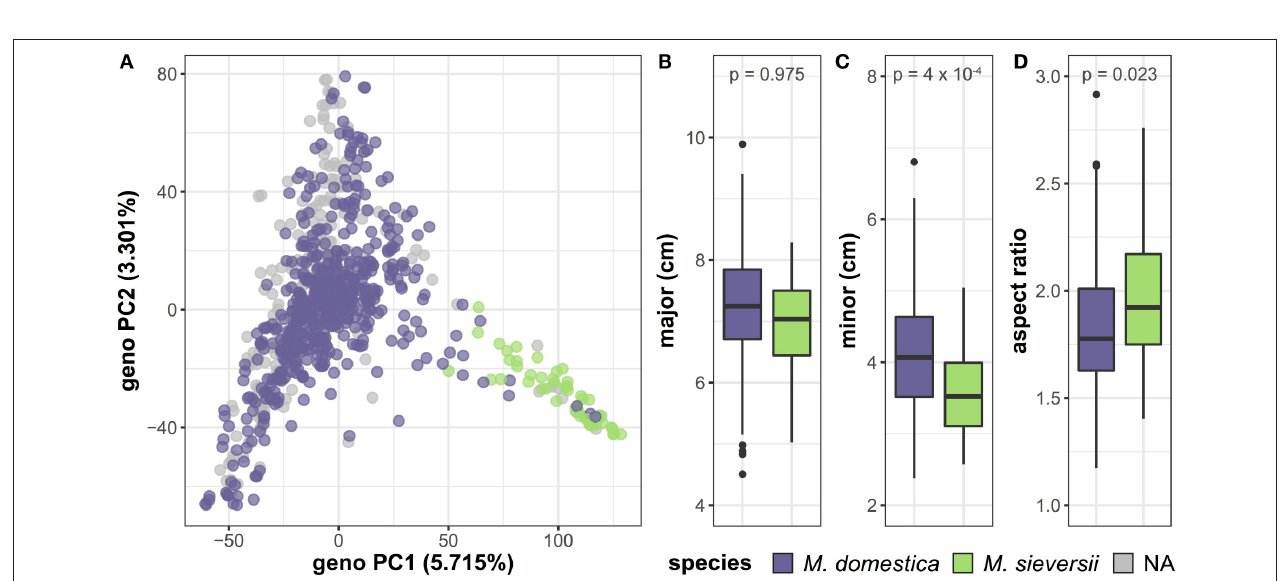
FIGURE 6 | Genetic and phenotypic comparison of the domesticated apple and its wild ancestor. PCs 1 and 2 were derived from 75,973 genome-wide SNPs and samples are labeled as M. domestica (purple), M. sieversii (green) or unknown (gray) (A) . M. domestica leaves do not differ from M. sieversii leaves along the major axis (B) , but they have a larger minor axis (C) and aspect ratio (D) . P -values reported are Bonferroni-corrected based on multiple comparisons ( Table S4 ). Species labels are based on USDA classification.